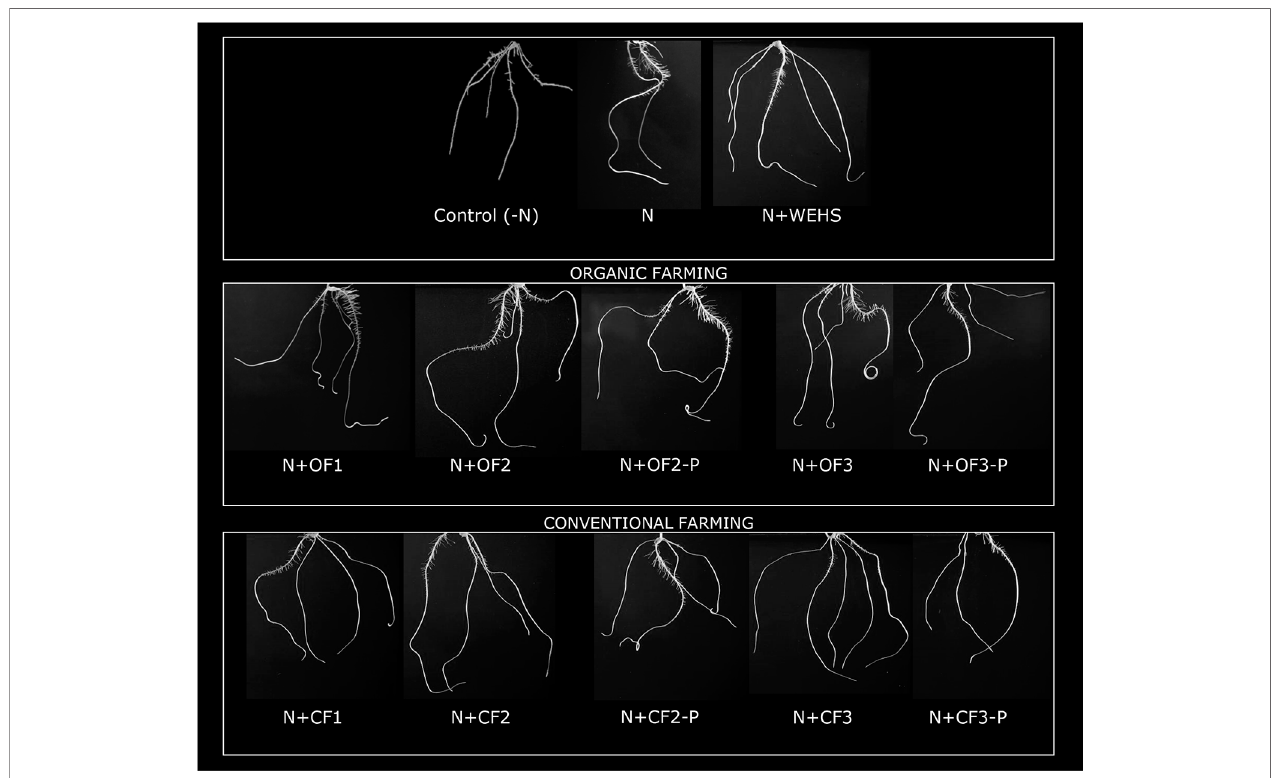
FIGURE 2 | Representative pictures of whole root system of maize plants (5 days old) after 24 h of treatment (in nutrient solution): N-free nutrient solution [ Control (-N) ], nutrient solution containing nitrate (0.5 mM Ca(NO 3 ) 2 ) with or without 5 mg C org L − 1 water-extractable humic substances (WEHS) (humic substances isolated from sphagnum peat; N+WEHS or N , respectively), nitrate (0.5 mM Ca(NO 3 ) 2 ) with dissolved humic substances (DHS) (5 mg C org L − 1 ) isolated from organic farming (OF) soils ( N+OF1 , N+OF2 , N+OF-P2 , N+OF3 , and N+OF-P3 ) or isolated from conventional farming (CF) soils ( N+CF1 , N+CF2 , N+CF-P2 , N+CF3 , and N+CF-P3 ). The code name of samples is reported in Figure 1